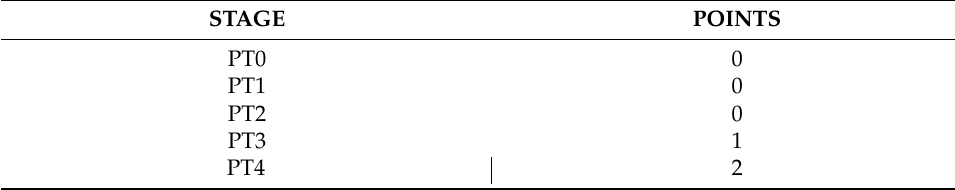
Table A7. Confirmed tumor stage.